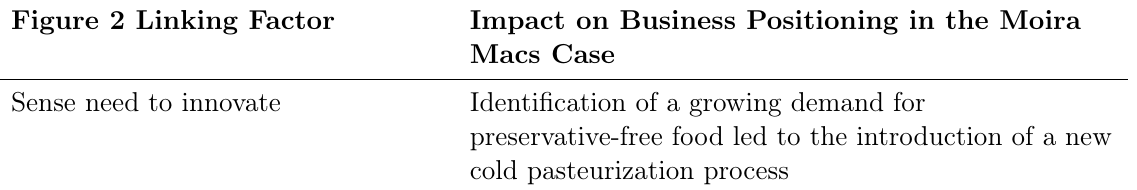
Figure 2 Linking Factor Impact on Business Positioning in the Moira Macs Case Sense need to